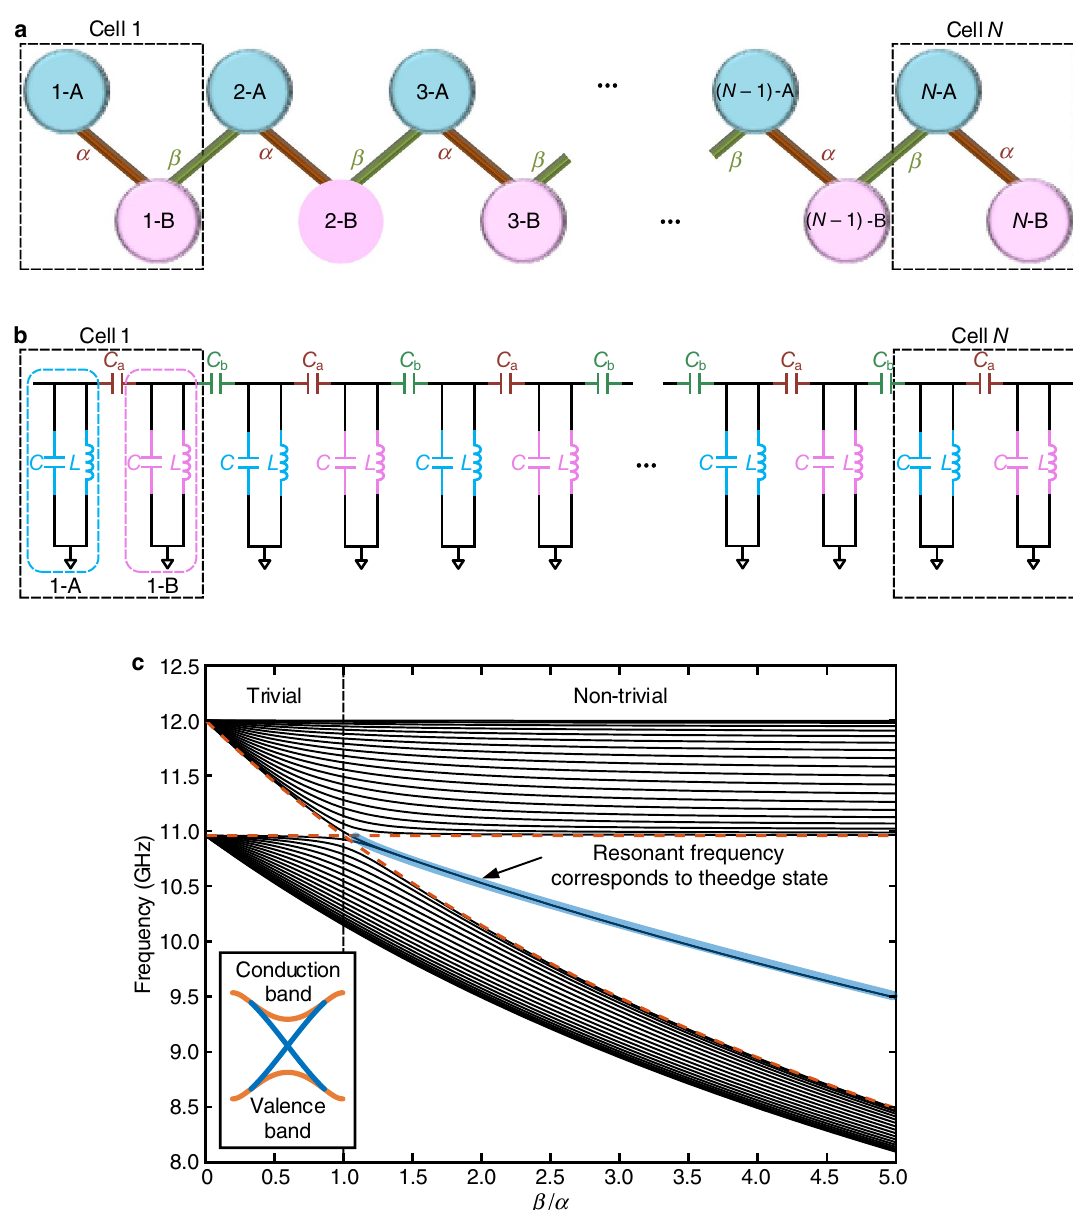
Figure 1. Illustration of the theoretical SSH model and one of its equivalent electronic circuit models. ( a ) A general theoretical 1-D SSH model consisting of N cells. Each blue/pink circle represents a sub-unit A/B in the i th cell. ( b ) The schematic of an equivalent electronic circuit (i.e., a 1-D circuit chain) for the theoretical SSH model. Each cell in the 1-D circuit chain consists of two LC resonators coupled by a linear capacitor C a . Each cell is coupled to one another by a linear capacitor C b . All inductance and capacitance in different LC resonators are the same. c , Numerical simulation of the 1-D SSH circuit chain with 20 cells. The characteristic frequency is 12 GHz. C a is fixed at the designed value and C b is varied from 0 to 5 C a . Orange dashes outline ω c /( 2 π) f c = = 2 α) f 1 /( 1 2 β) f the bandgap edge frequencies calculated from √ 1 /( 1 c and √ c . The vertical black dash line is + + 1 . The edge state frequency at √ 1 /( 1 α β) f c the boundary between nontrivial and trivial regimes at β/α + + = is highlighted in blue. The inset is a conceptual diagram of a TI’s energy bands. Orange curves correspond to the bulk bands, and the blue curves correspond to the edge states at the